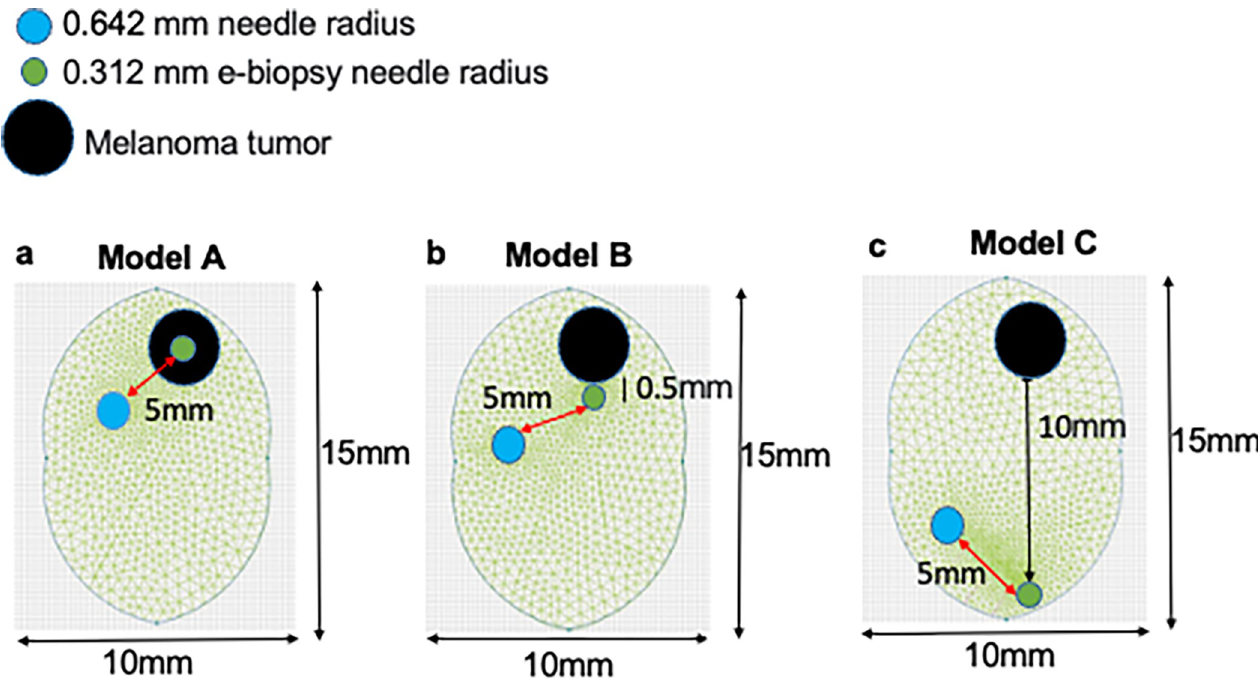
Fig 2. The geometry used for simulations of electric field distribution of the three experimental conditions: Center, margin, and healthy brain. a. e- biopsy sampling electrode is in the middle of the visible tumor (Center). b. e-biopsy sampling electrode is near the visible tumor margin (Margin). c. e-biopsy sampling electrode is far away from the tumor (Healthy